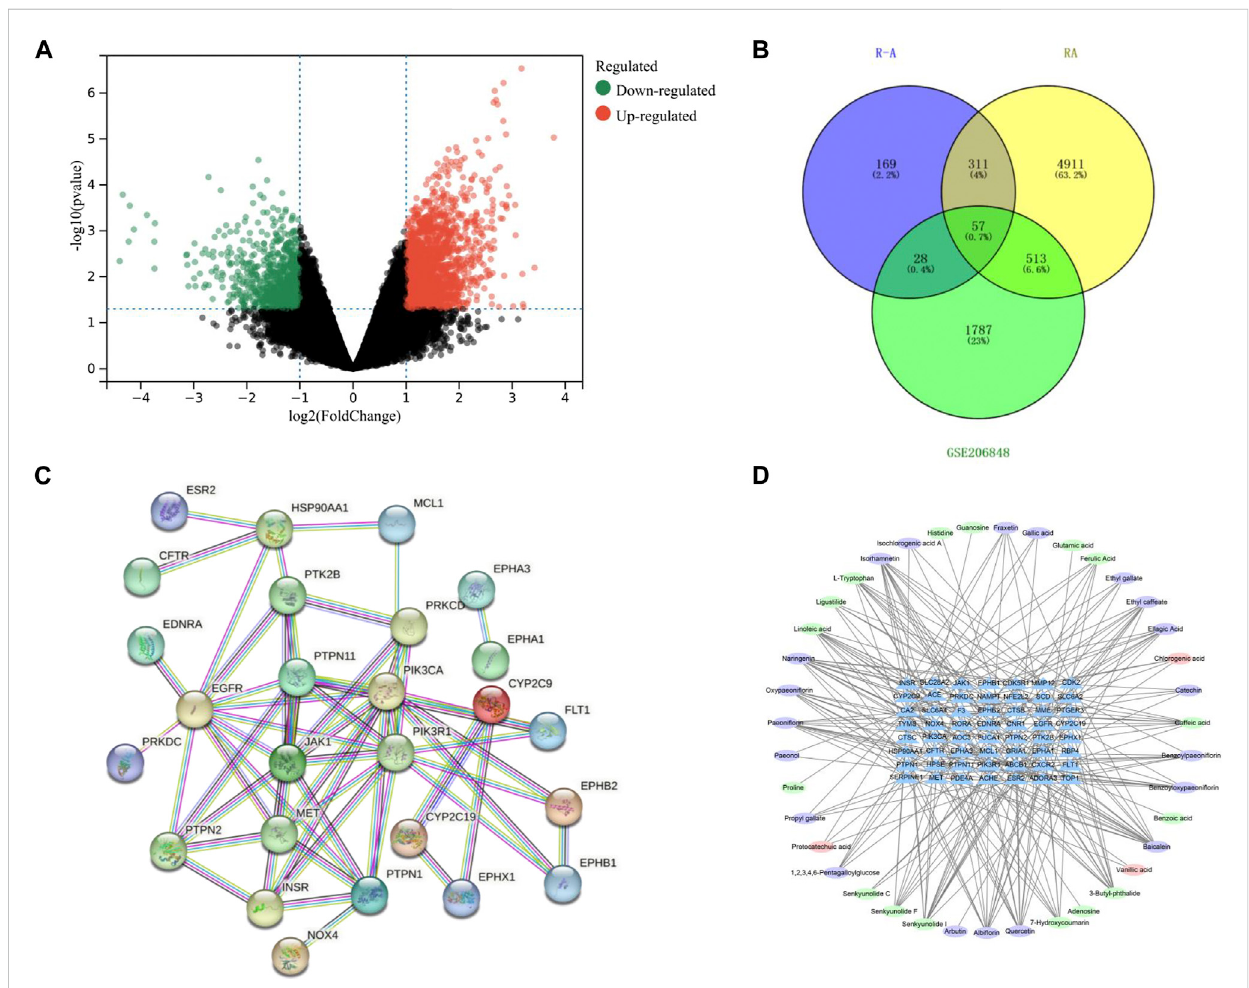
FIGURE 3 (A) Volcano plot of differential genes on GSE206848 chip (no differential genes are shown in black, the gene is upregulated and shown in red. The gene is downregulated and shown in green). (B) Venn diagram of the active ingredients in the P-A drug pair and RA target. (C) PPI network. (D) Network diagram of active ingredient – target pairs of the P-A drug pair (oval represents chemical compositions, and triangle represents targets).